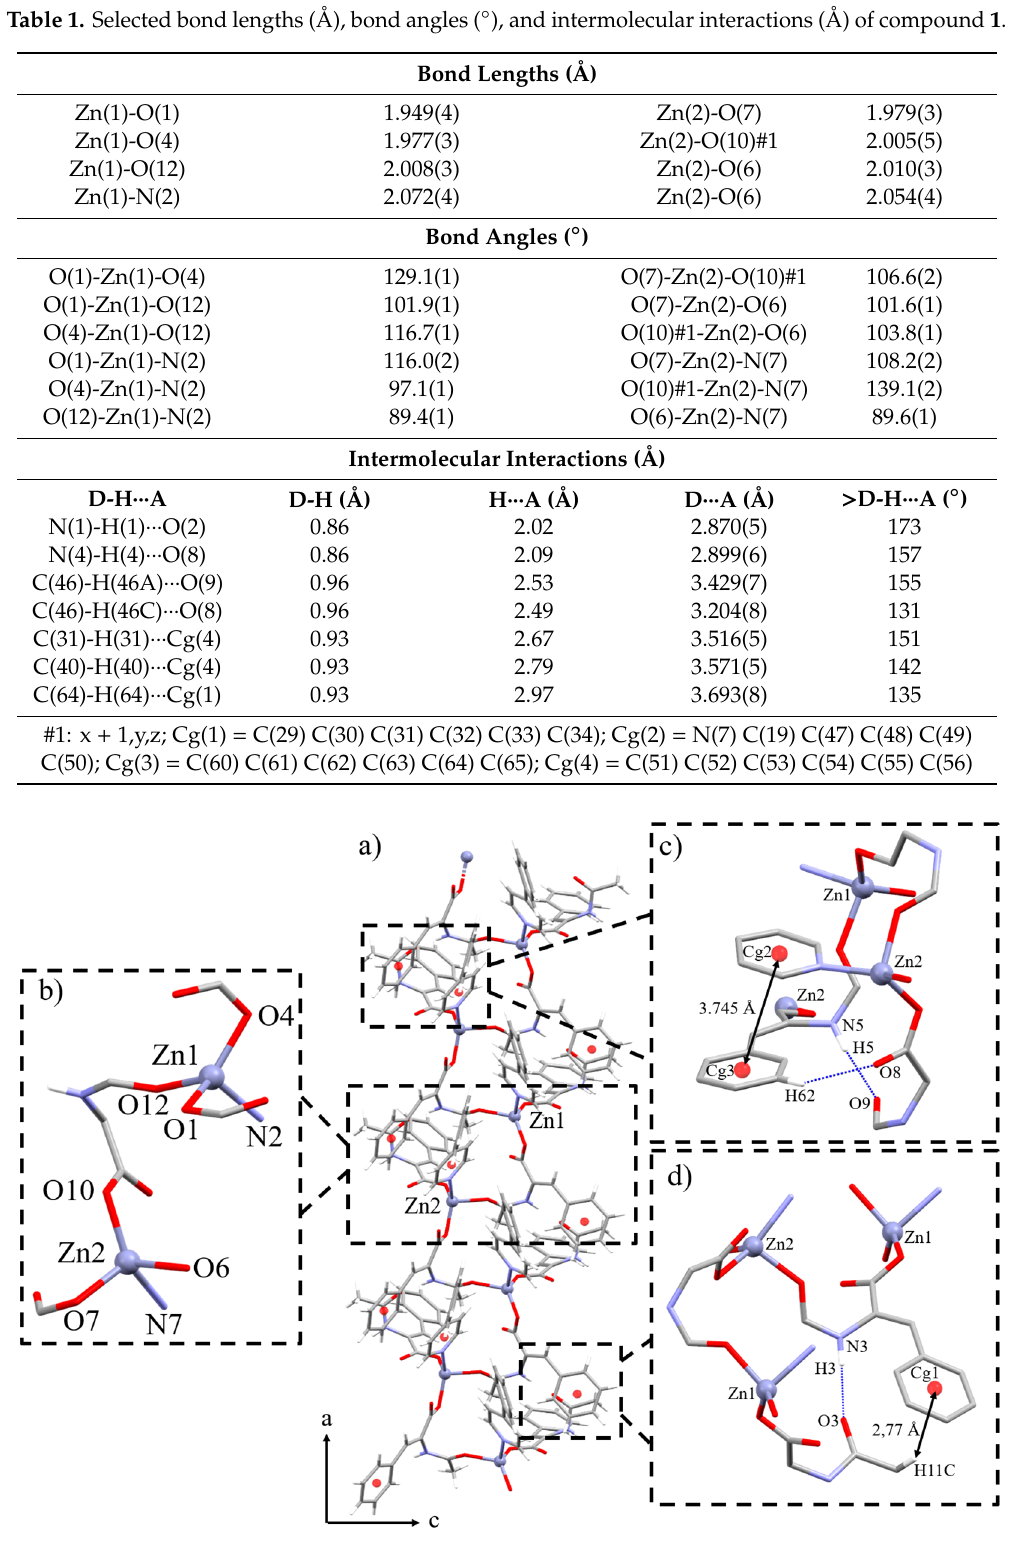
Figure 1. ( a ) General view of the polymeric chain of 1 along the a axis. In detail view of ( b ) core atoms of the polymeric chain. ( c ) N-H ··· O, C-H ··· O, and π ·· π intramolecular interactions. ( d ) N-H ··· O and C-H ··· π intramolecular interactions. The phenyl, pyridyl, and other atoms which do not participate in any intramolecular interaction have been omitted for clarity in the detailed views.